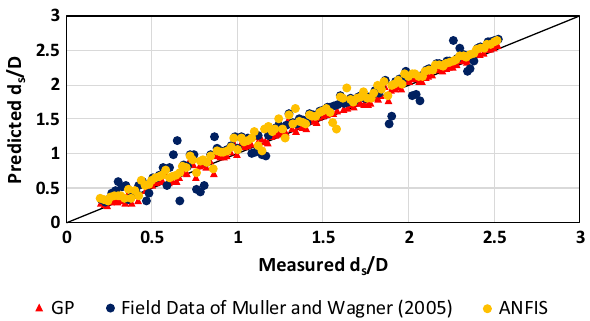
Fig. 11 ANFIS- and GP-predicted values of d